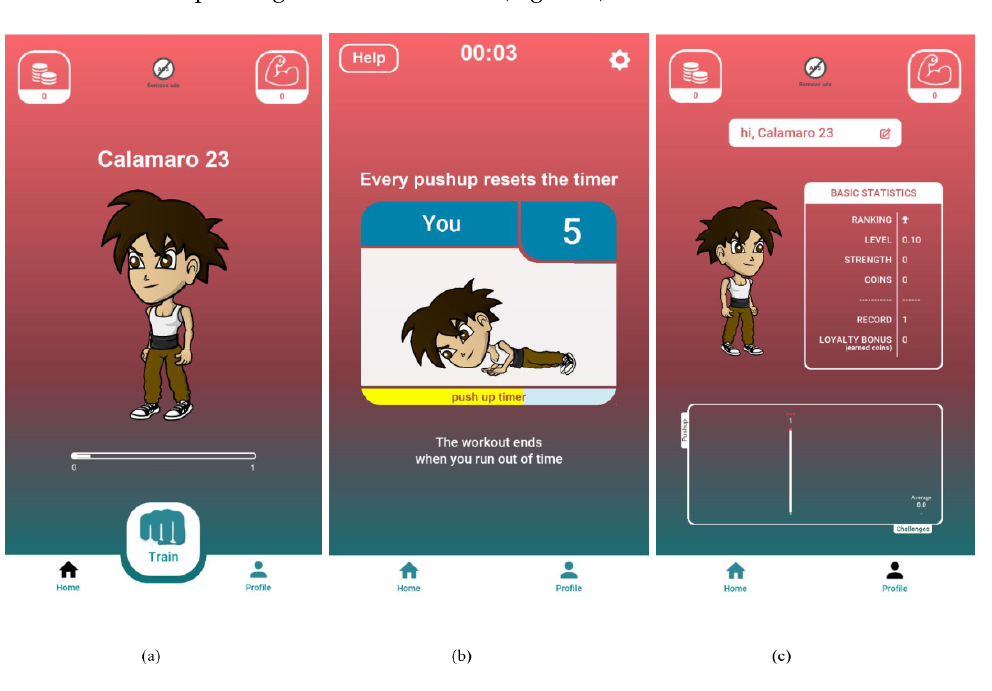
Figure 1. Screenshot of the app: Counter Version (C). ( a ) the homepage of the app, ( b ) a training session, ( c ) the profile